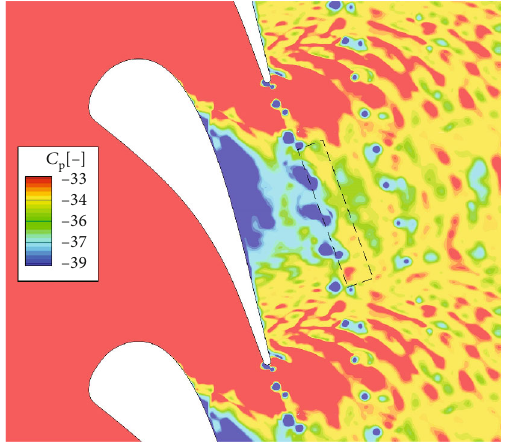
Figure 9: Pressure coe ffi cient distribution of